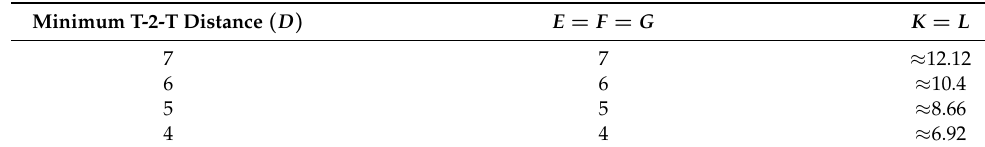
Table 3. Turbine to turbine (T-2-T) separation distances in rotor diameters.